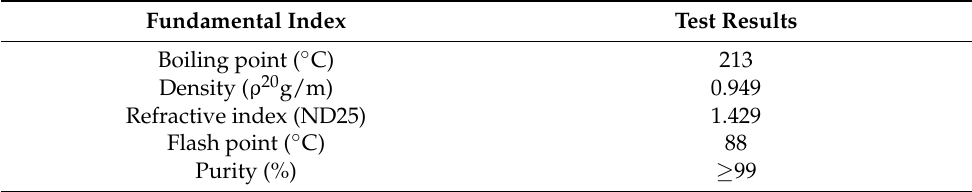
Table 4. Properties of KH550.